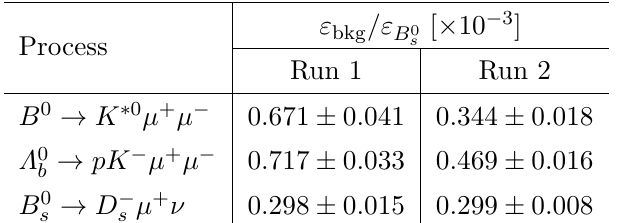
Table 1. Efficiencies of background decay processes relative to that of the decay B 0 evaluated using simulated samples. The uncertainties are due to limited sizes of these